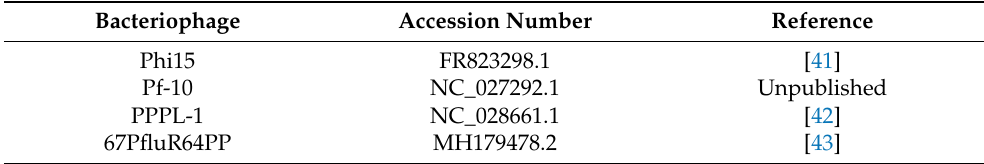
Table 2. List of bacteriophage genomes used in this